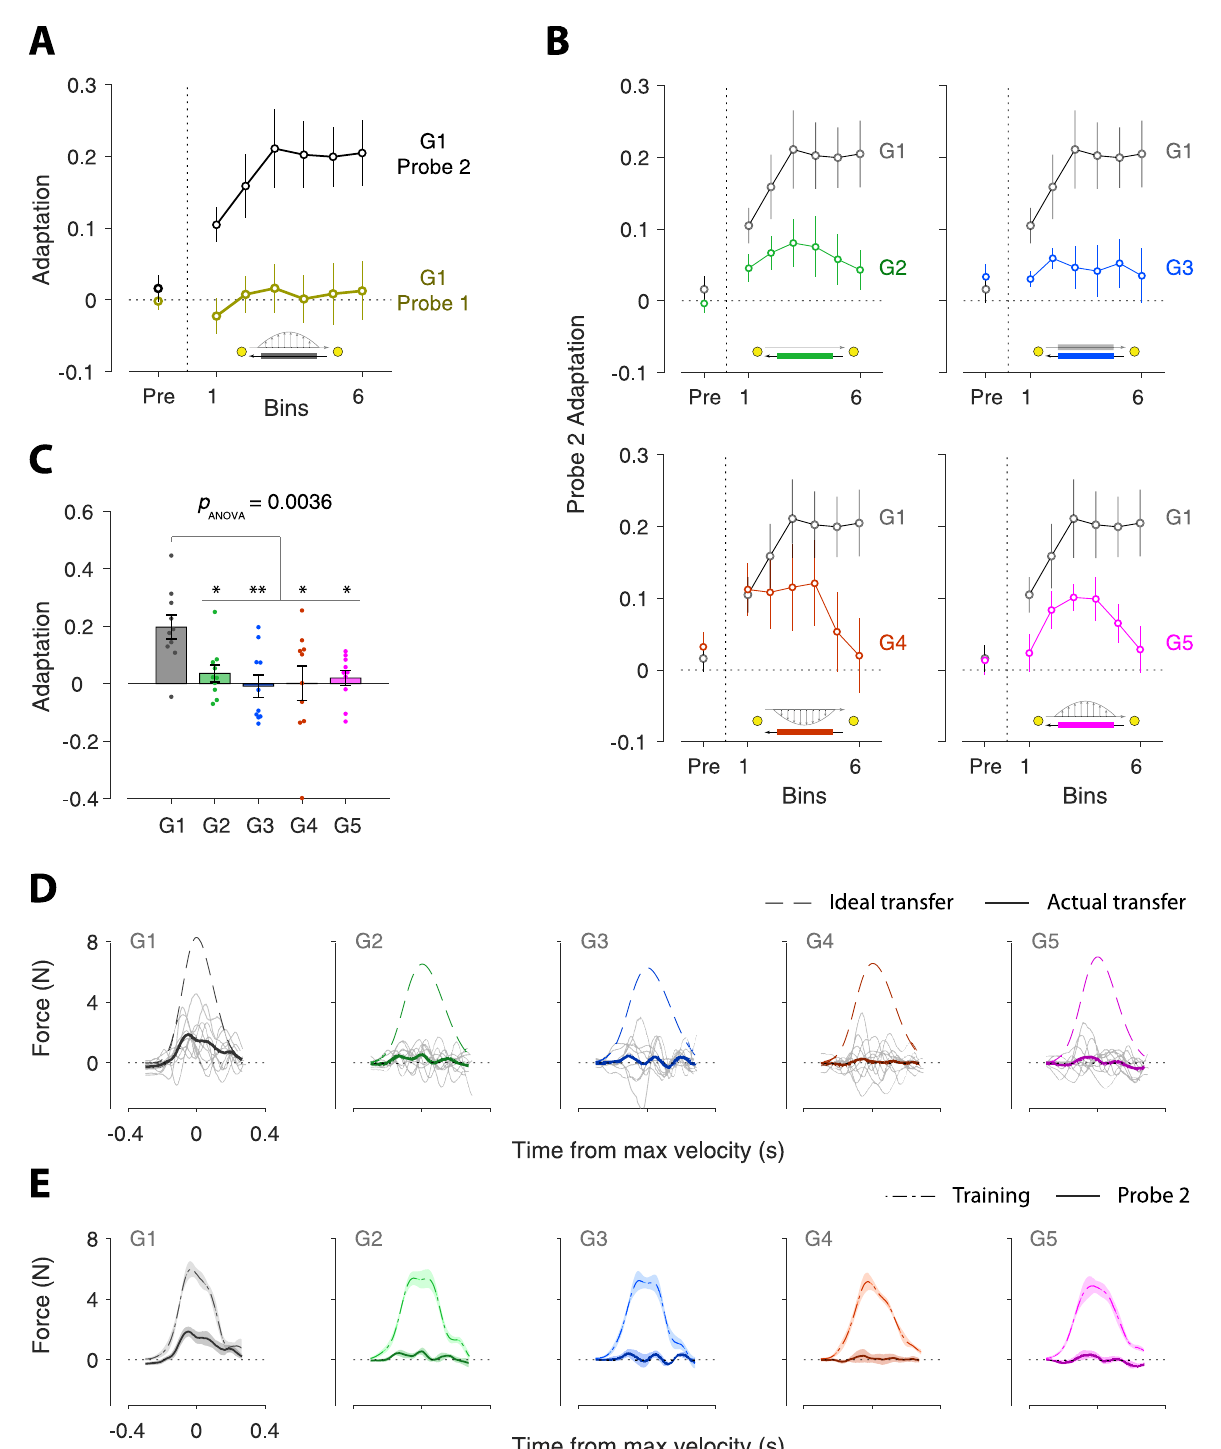
Fig 3. Adaptation during Probe2 for the five groups. A . Adaptation for the Return trials of Probe2 for G1 (mean ± s.e. across subjects in 6 bins of 12 trials each). Probe1 is shown for comparison. The Pre data point shows the last channel trial of the preceding null field (“washout”) phase. B . Adaptation for Return trials of Probe2 for G2 to G5. For comparison the Probe2 phase of G1 is also shown (black), plotted as in A . C . The baseline- corrected adaptation (mean ± s.e.) for the last bin of Probe2 for each group. This is obtained by subtracting the baseline adaptation (i.e., ‘Pre’ in panel B ) from the adaptation of the final bin. The small dots represent the individual data. The p -values reflect the Tukey-Kramer corrected